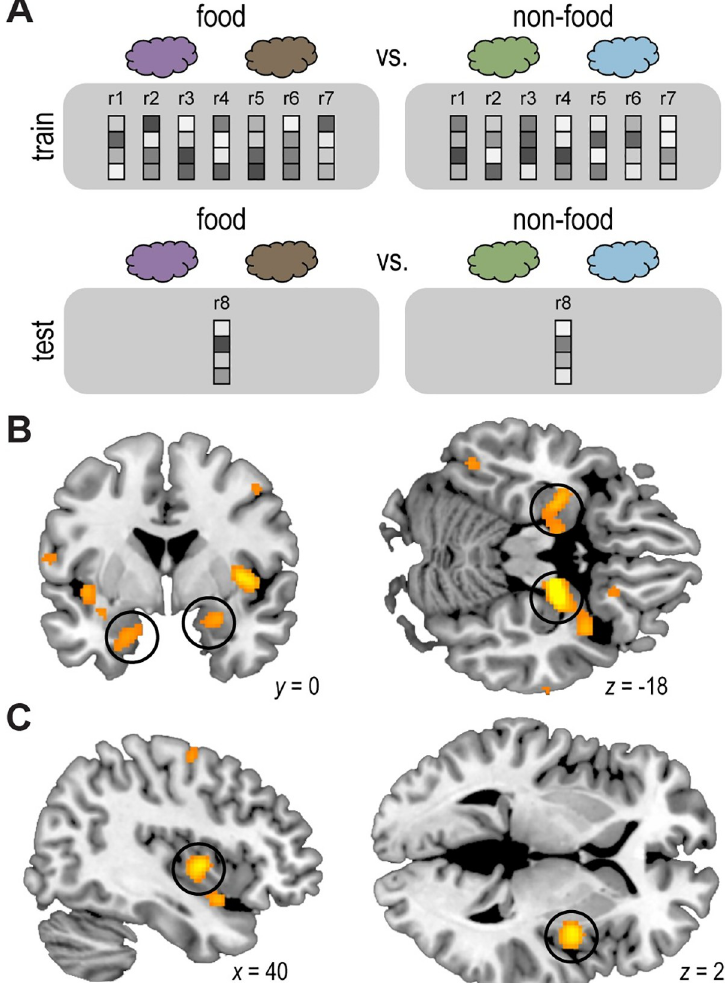
Fig 3. fMRI ensemble patterns in olfactory/limbic areas and insula discriminate food and nonfood odors. (A) Schematic of searchlight decoding analysis. For each searchlight sphere, an SVM classifier was trained and tested on ensemble patterns of fMRI activity evoked by pure food (average of cinnamon bun and pizza) vs. nonfood (average of cedar and pine) odors during both pre- and post-meal sessions using a leave-one-run-out cross-validation approach. (B, C) Significant decoding accuracy reflecting food vs. nonfood pattern discrimination in bilateral olfactory/limbic brain areas (left: x = − 28, y = − 6, z = − 18, t (29) = 6.81, p FWE = 0.003; right: x = 20, y = − 8, z = − 18, t (29) = 10.11, p FWE < < 0.001; C; circled). The group-level t-map is 0.001; B; circled) and right insula (x = 40, y = − 2, z = 2, t (29) = 7.85, p FWE thresholded at p FWE < 0.05 and overlaid on a canonical structural image. The whole-brain statistical map can be viewed at neurovault.org/collections/EWYJXOKG/images/510268/. fMRI, functional magnetic resonance imaging; SVM, support vector